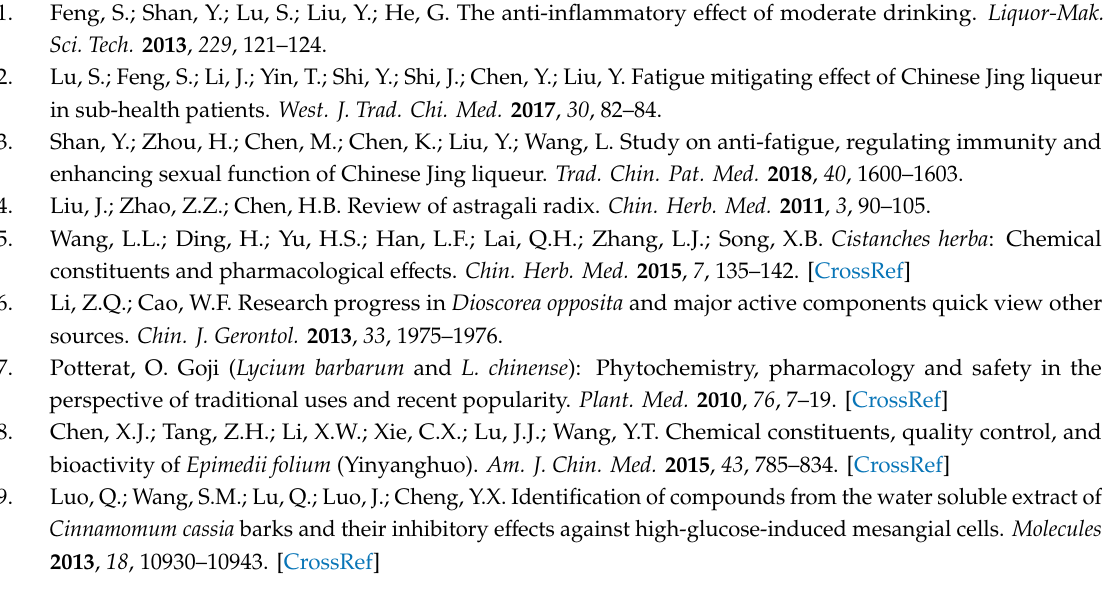
Figure S1: Structure of 7 . Table S1: 1 H and 13 C NMR data of 7 (400 MHz, CD 3 OD). Figure S2: HR-ESI-MS spectrum of 7 . Figure S3: 1 H-NMR spectrum of 7 (400 MHz, CD 3 OD). Figure S4: COSY (Correlation Spectroscopy) spectrum of 7 (400 MHz, CD 3 OD). Figure S5: HSQC (Heteronuclear Single Quantum Coherence) spectrum of 7 (400 MHz, CD 3 OD). Figure S6: HMBC (Heteronuclear Multiple Bond Correlation) spectrum of 7 (400 MHz, CD 3 OD). MS, NMR, and references of the other known